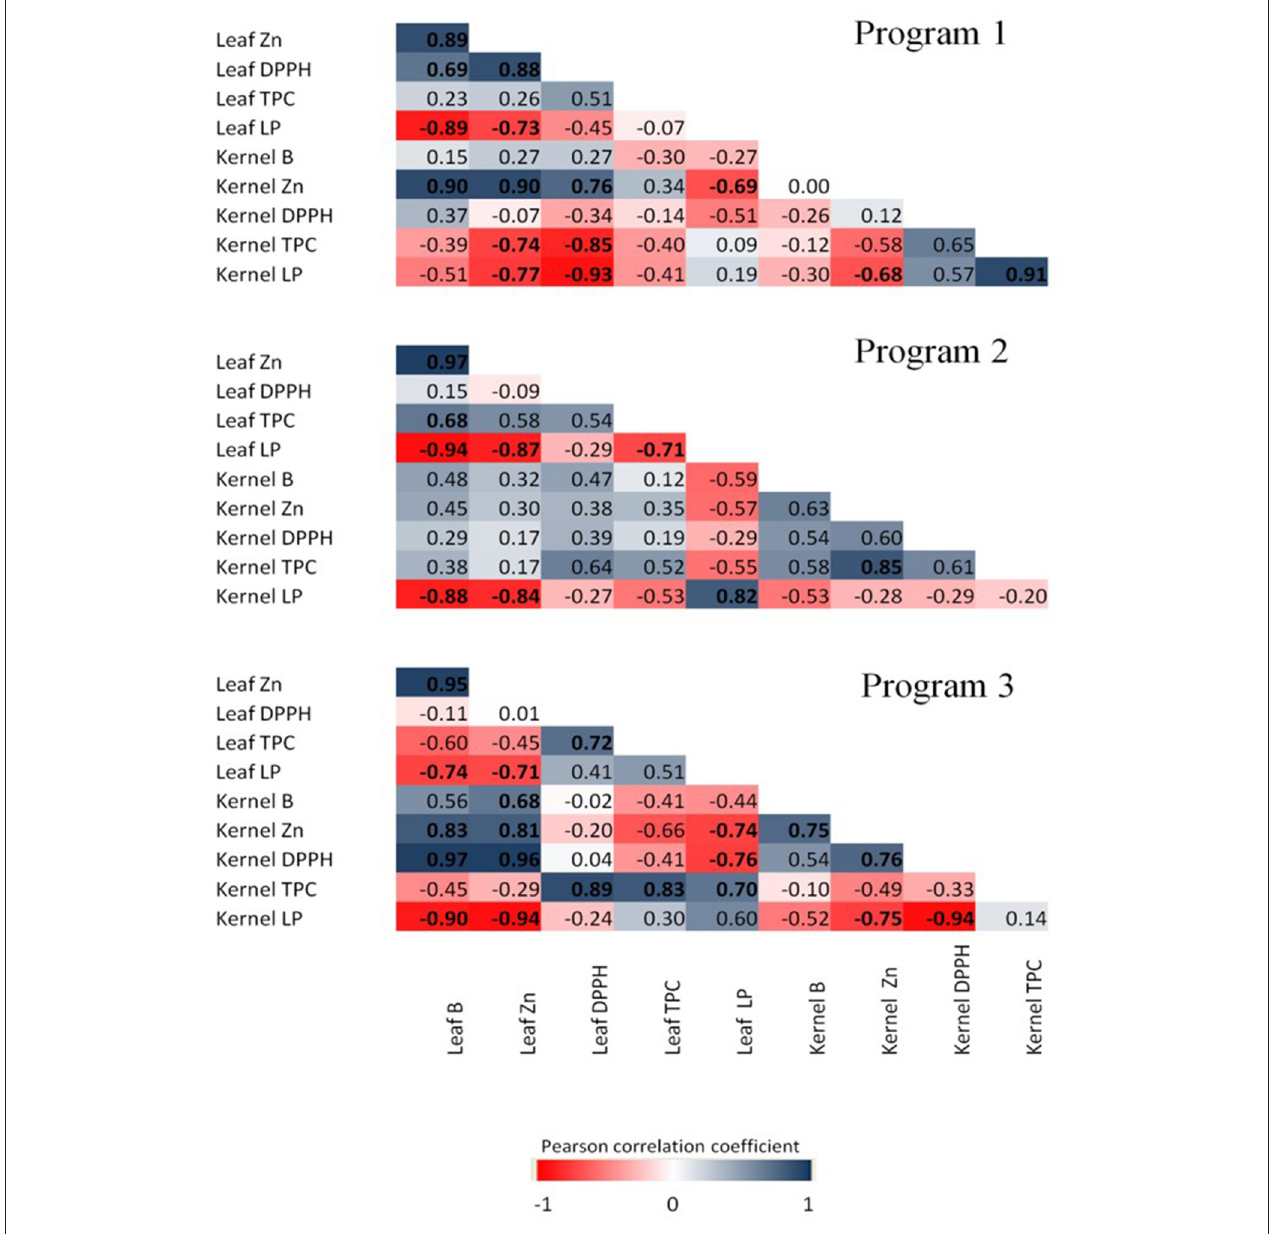
FIGURE 7 | Pearson’s correlation coefficient matrix among nutrient concentration and antioxidant features of cultivar TDG. Correlation was calculated at three spraying programs (1, 2, and 3), and three B (0, 800, and 1,600mg L − 1 ) and Zn (0, 400, and 800mg L − 1 ) concentrations. Pearson’s coefficients that are significant at P < 0.05 are indicated by boldface. Positive and negative correlations are distinguished by blue and red colors, respectively.